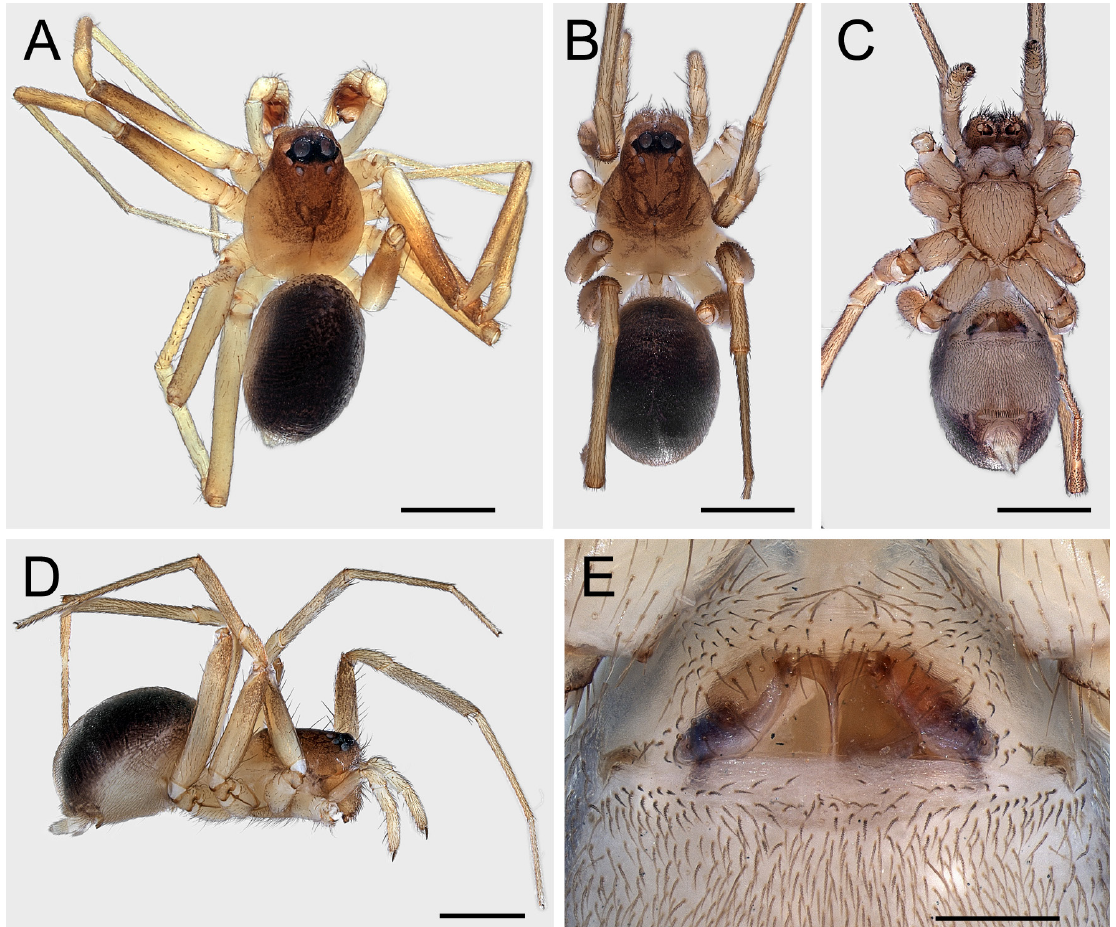
Fig. 1. Acanthinozodium crateriferum sp. nov. A . Holotype ♂. B–E . Paratype ♀. A . Male habitus, dorsal view. B . Female habitus, dorsal view. C . Idem, ventral view. D . Idem, lateral view. E . Epigyne, ventral view. Scale bars: A–D = 1 mm; E = 0.2